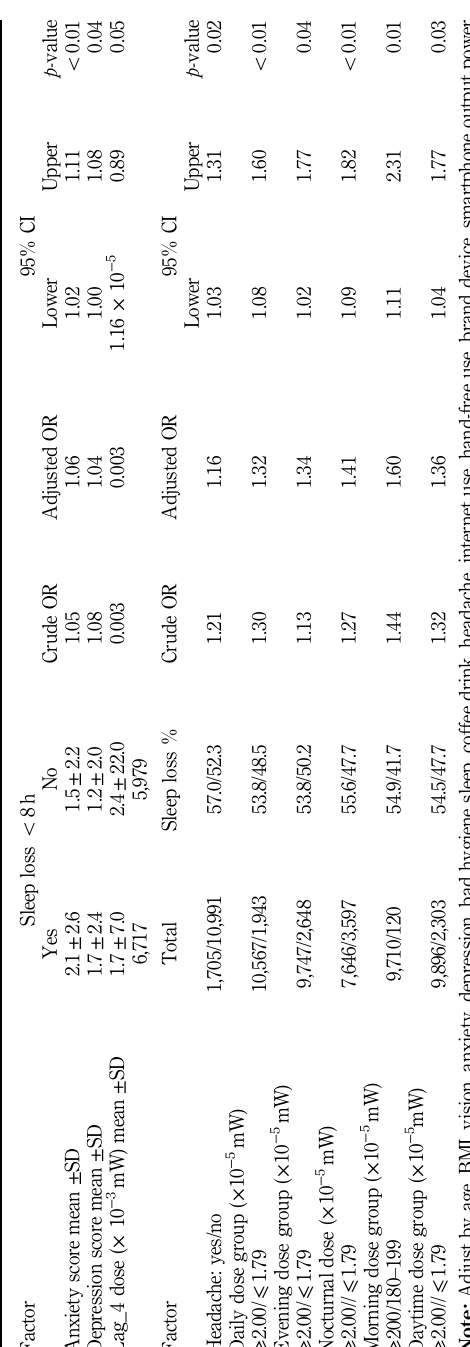
Table III. Odds ratios (OR) of sleep loss and their 95% confidence intervals for each factor and daily dose adjusted for all other factors using GEE (Exchangeable, QIC ¼ 15,141.01, QICC ¼